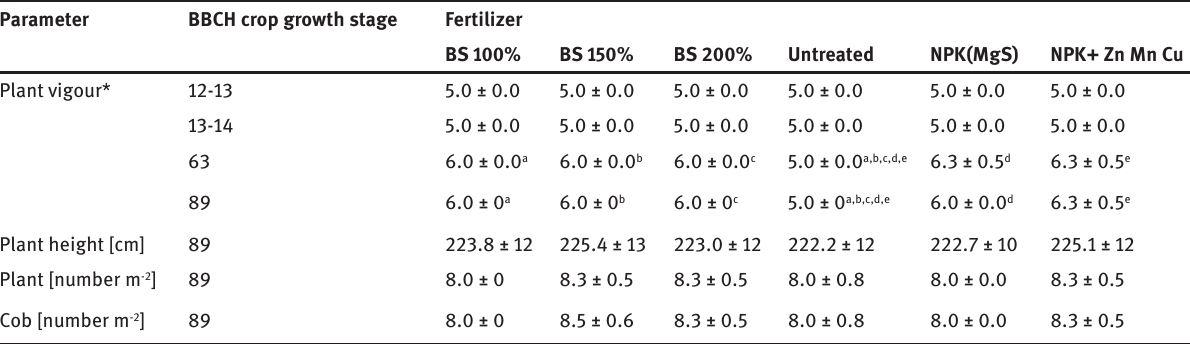
Table 3: Effect of fertilization on plants (vigour: 0-10 scale, according to EPPO standards). Parameter